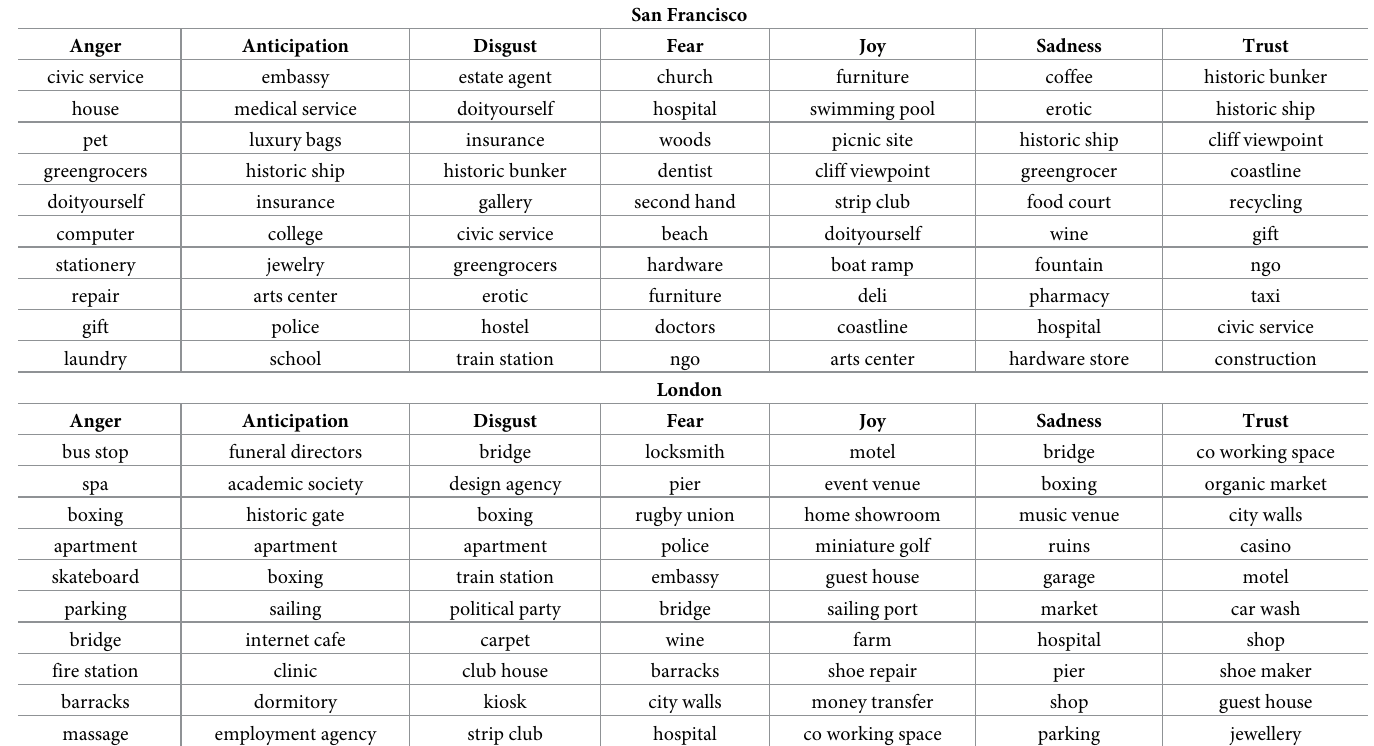
Table 3. The top 10 POI for each emotion for the cities of San Francisco and